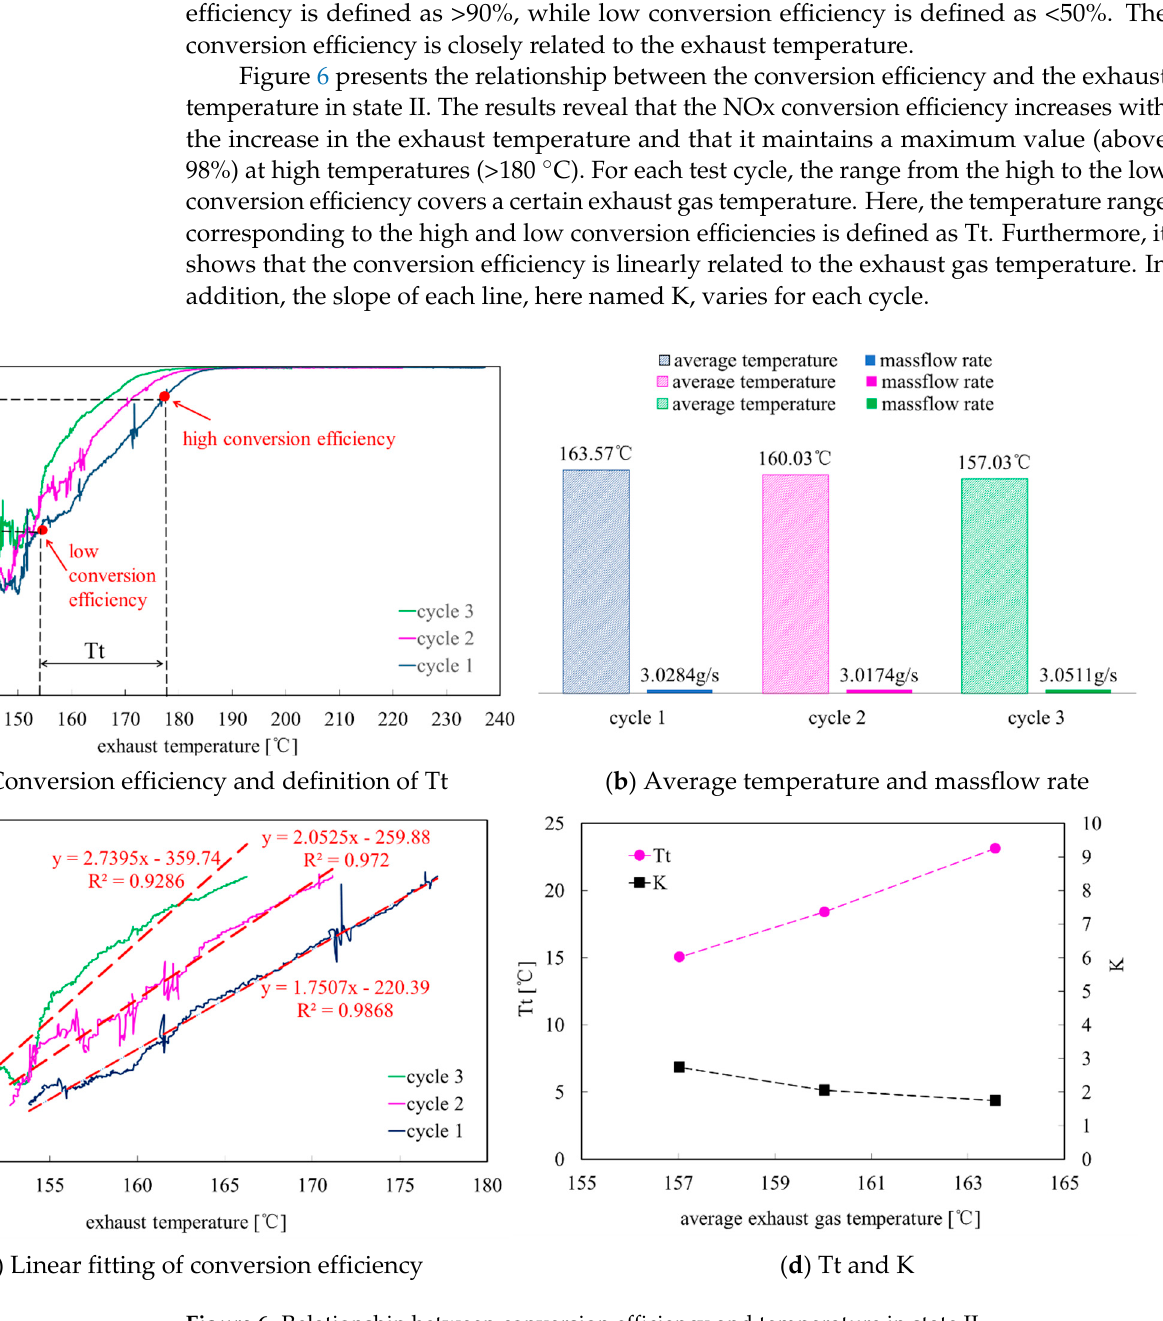
Figure 6. Relationship between conversion efficiency and temperature in state II.